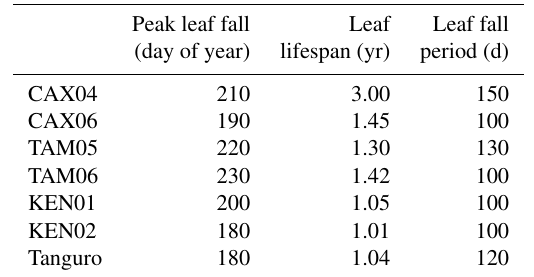
Table 4. SPA calibrated leaf litterfall parameters for plots across an Amazon MCWD gradient. Peak leaf fall is the day of year leaf litter- fall reaches its maximum, leaf lifespan reflects maximum lifespan of leaves and leaf fall period is the number of days over which sys- tematic increases in leaf fall occur. Leaf litterfall parameters were calibrated against GEM field estimates to capture leaf litterfall and timing.